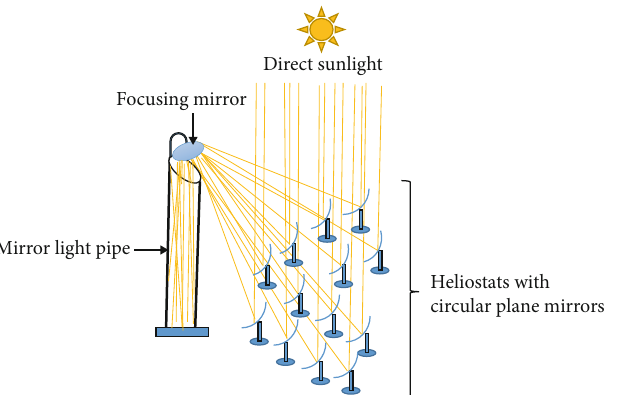
Figure 7: Conceptual design of solar tower heliostat array daylighting system for the illumination of multi fl oor buildings via mirror light pipe (source: adapted from